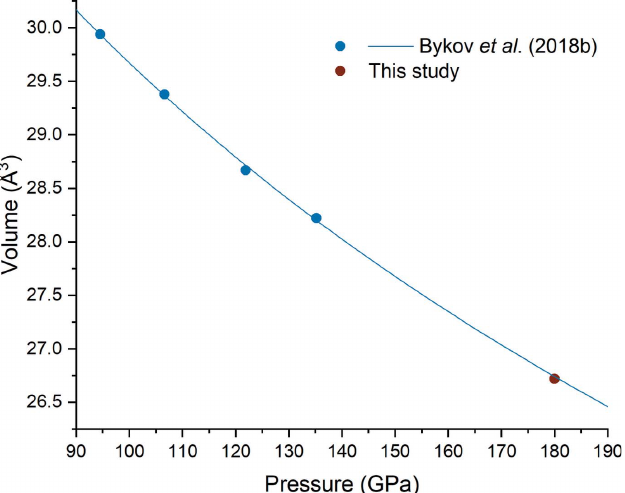
Figure 2 Pressure-dependence of the unit-cell volume of FeN 4 . Blue points and the equation of state (blue line) are taken without modification from Bykov et al. (2018 a ) [ V 94.5 = 29.94 (4) A˚ 3 , K 94.5 = 603 (22) GPa, K 0 94.5 = 4.0 (fixed)]. Red point – current study.